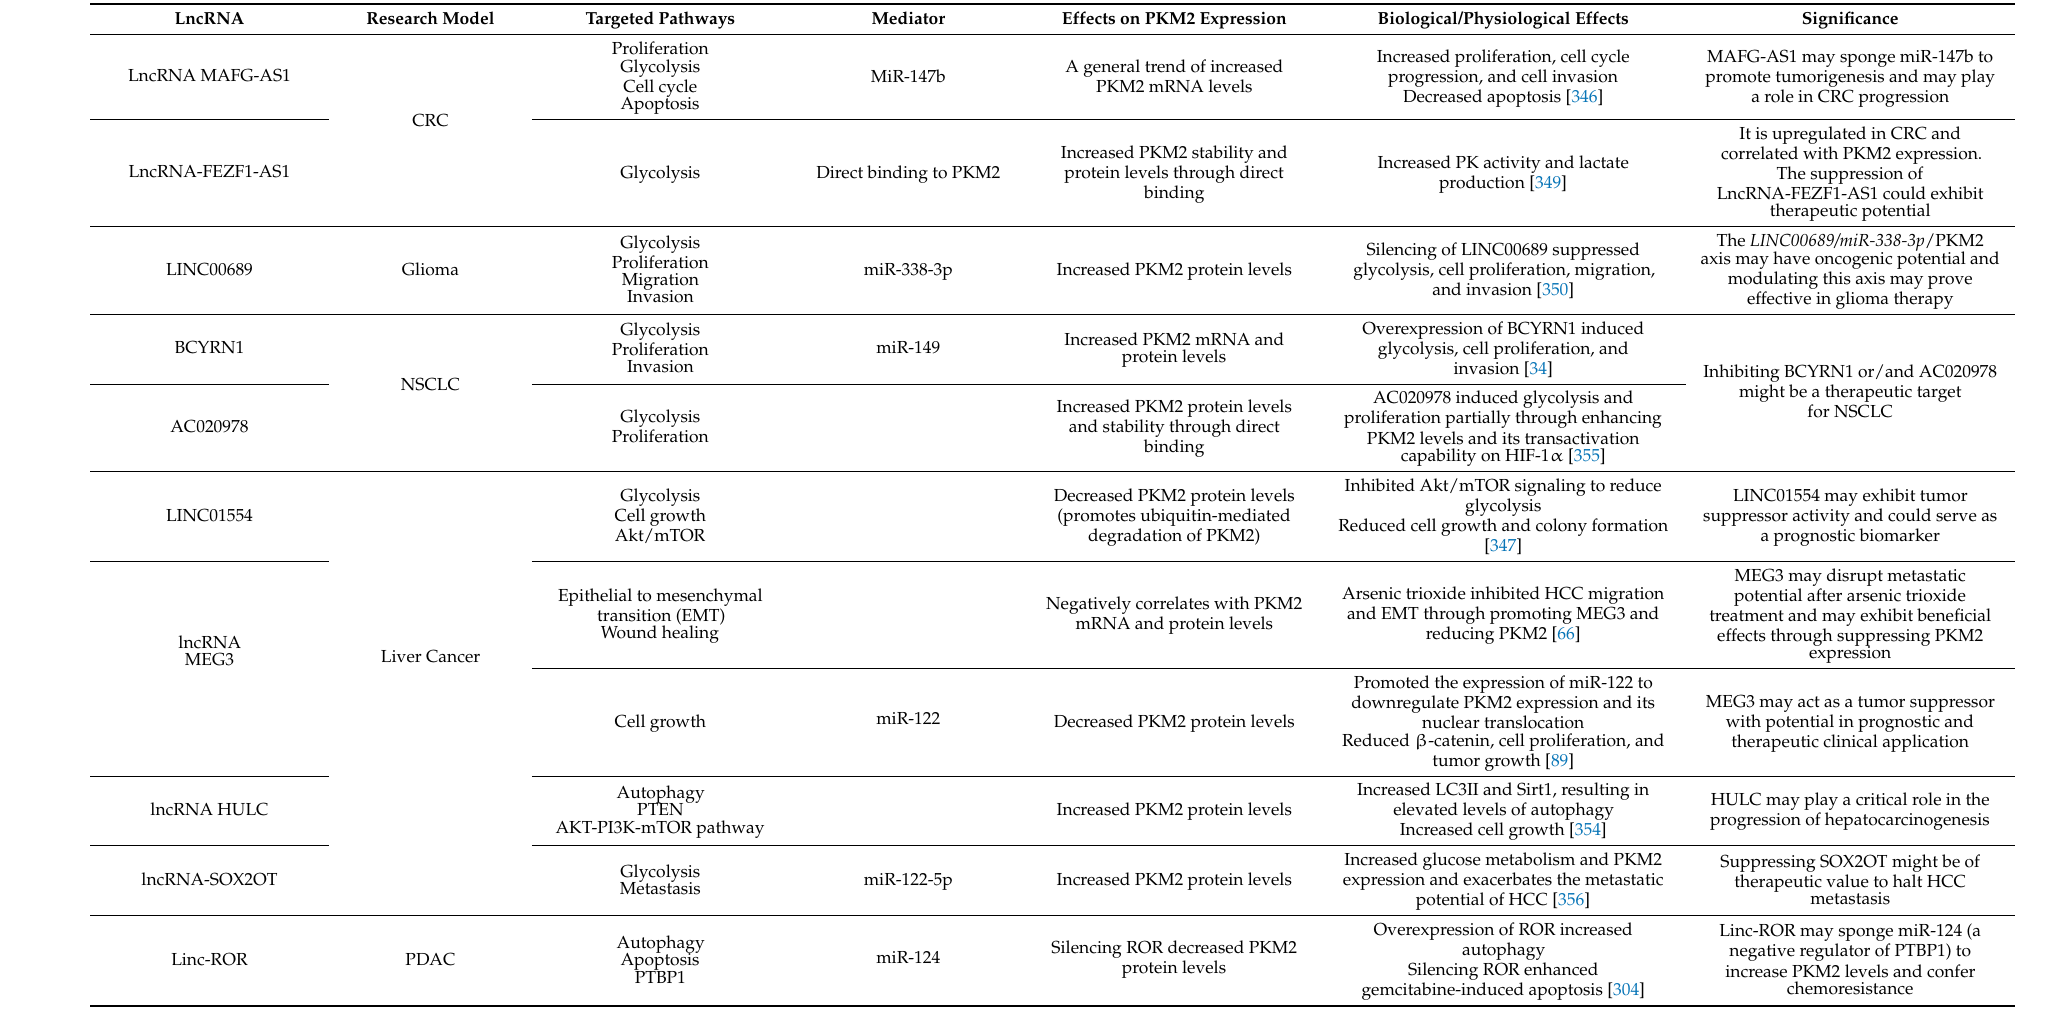
Table 3. Role of some PKM2/long non-coding RNA in